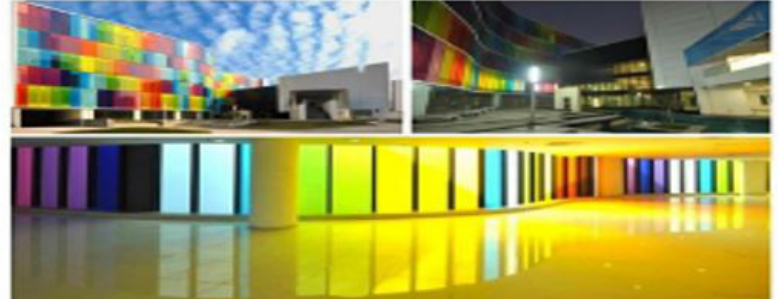
Figure 13. internal shoot of IMI Kolkata centre- Kolkata,West Bengal, India. (Abou-ghazala,Fared, & Al-Shami, 2014)